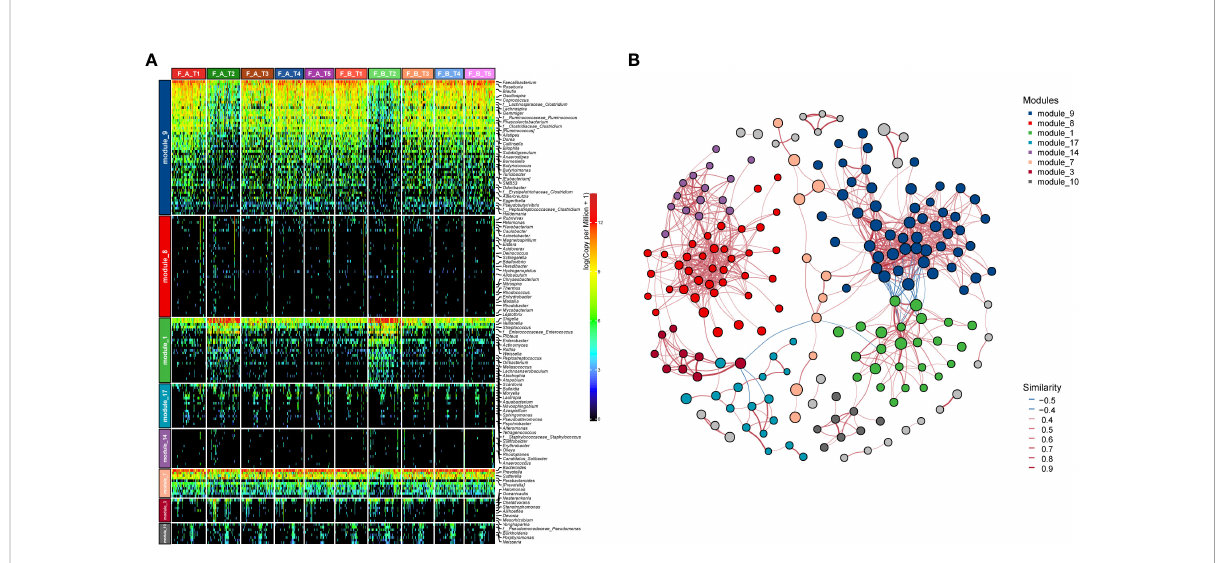
FIGURE 4 Co-occurrence network reveals the transformation of gut microbial pattern and their interconnection. (A) Heatmap shows the relative abundance of genera in each module. An obvious transformation of module_9 to module_1 was observed at T2, which was reverted from T3 to T5. (B) Signi fi cant co-occurrence and co-exclusion relationships among the modules. Each node represents a genus colored by module and its size is proportional to the relative abundance. Edge color indicates the positive (red) and negative (blue) association. The width of each line exhibits the correlation strength among